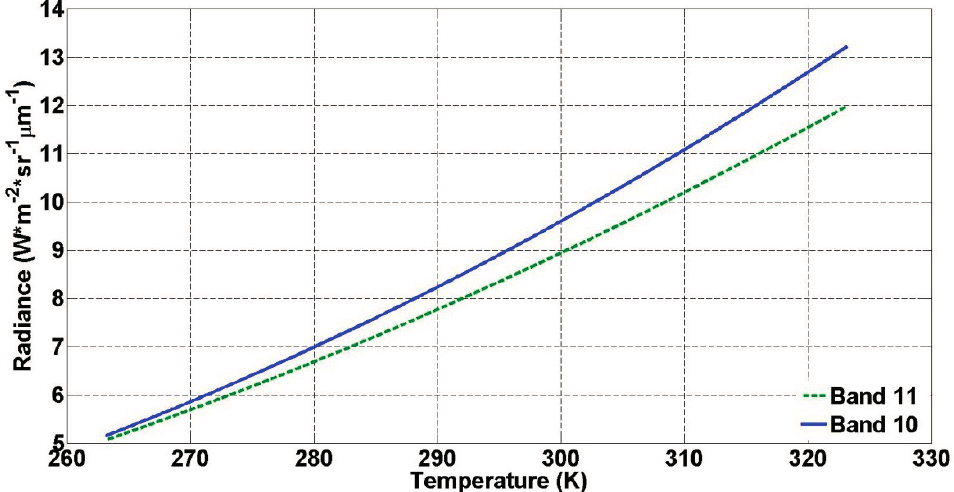
Figure 2. Relationship between temperature and radiance for Thermal Infrared Sensor (TIRS) band 10 and